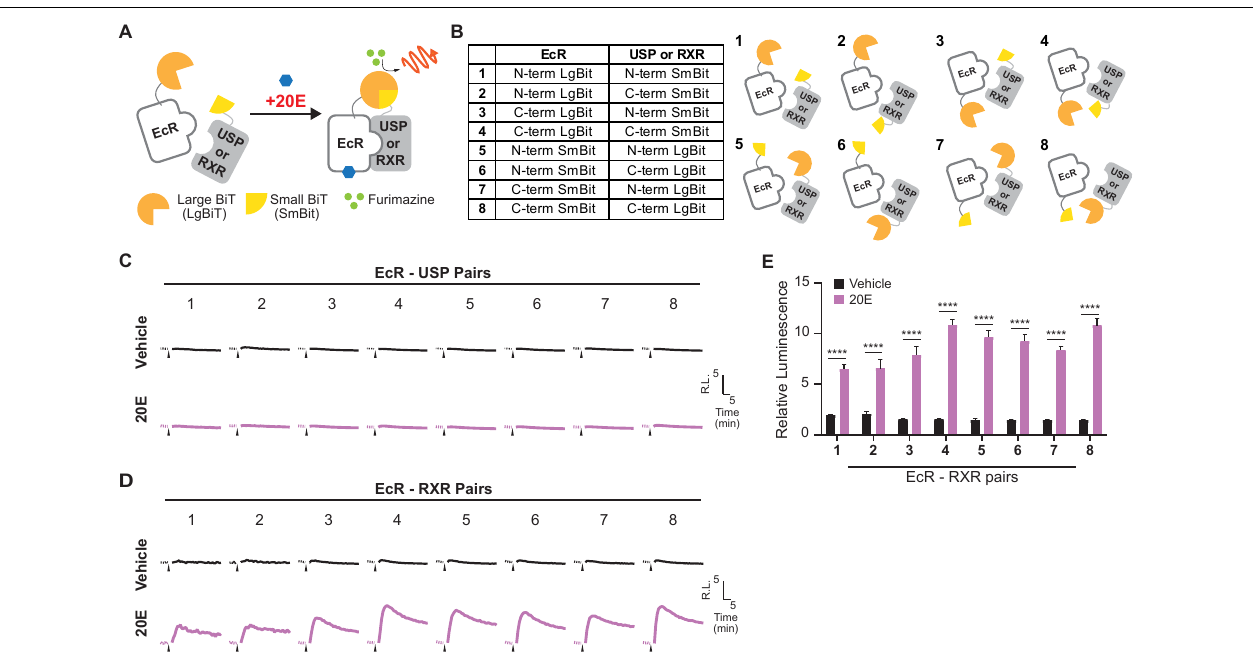
FIGURE 1 | Optimization of the EcR-RXR NanoBiT assay. (A) Schematic diagram of the NanoBiT 20E reporter system. EcR and either USP or RXR are expressed as fusion proteins with LgBiT and SmBiT, respectively. When the NanoBiT partners are brought in close proximity by EcR dimerization with USP or RXR in the presence of 20E, the NanoBiT partners form a functional luciferase enzyme which produces an observable light signal in the presence of the substrate furimazine. (B) Table (left) and schematics (right) showing the fusion protein pairs used in optimization testing. Eight different options are available as LgBiT or SmBiT could be fused to either protein and the fusion at either the N- or C-terminus. (C,D) Mean time-course changes of the relative luminescence in HEK293T cells expressing EcI and each of the NanoBiT EcR-USP (C) or EcR-RXR (D) combinations 1–8 listed in panel (B) . Black triangles indicate the time point when either EtOH or 10 µ M 20E was added to the medium. Data were normalized to the average of the basal luminescence reading immediately prior to treatment (dashed lines). R.L., relative luminescence. (E) Maximum relative luminescence from the EcR-RXR pairs for each of the combinations 1–8 listed in panel (B) . Bars represent means ± S.E.M. ( n = 3). Analysis by two-way ANOVA identified a significant interaction of the NanoBiT pair in response to the 20E treatment [ F ( 7 , 32 ) = 8.32, p < 0.0001]. **** p < 0.0001 by multiple comparisons using Sidak’s correction.